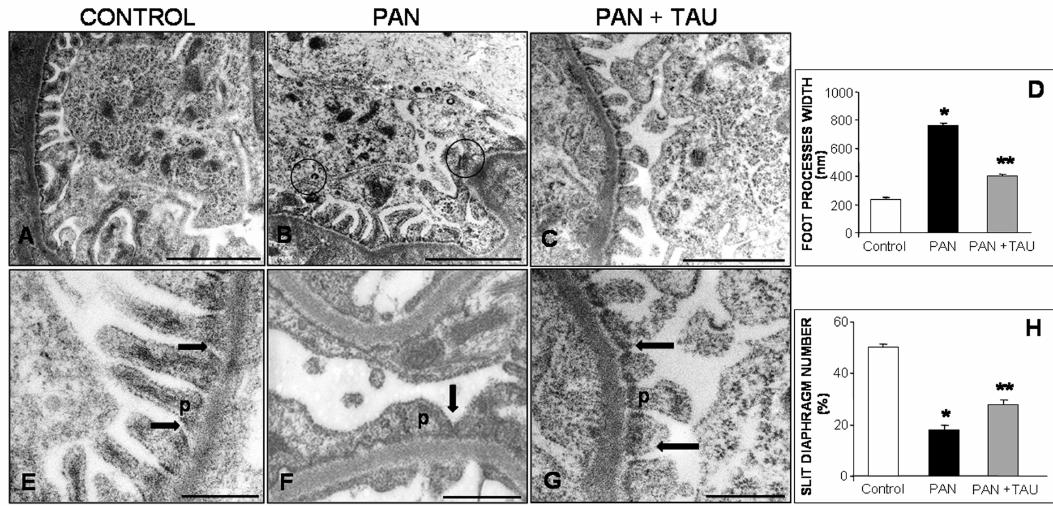
Figure 1. Podocyte damage. Dietary TAU reduced podocyte damage in PAN. Transmission electron micrographs of glomerular podocytes in ( A – E ) control, ( B – F ) PAN-injected rats, or ( C – G ) with TAU supplementation. In the PAN group, podocytes showed tight junctions (circled) together with pedicels feet (p) fusion and reduced slit diaphragm number (arrow). These changes were improved by TAU pre-treatment and were almost similar to control rats. ( A – C ) bar represents 1 µm and ( D – F ) bar represents 500 nm. Quantitative analysis of ( D ) foot processes width and ( H ) slit diaphragm number. Data are expressed as means or percentages. * p < 0.05 significant versus control group; ** p < 0.05 significant versus PAN group.